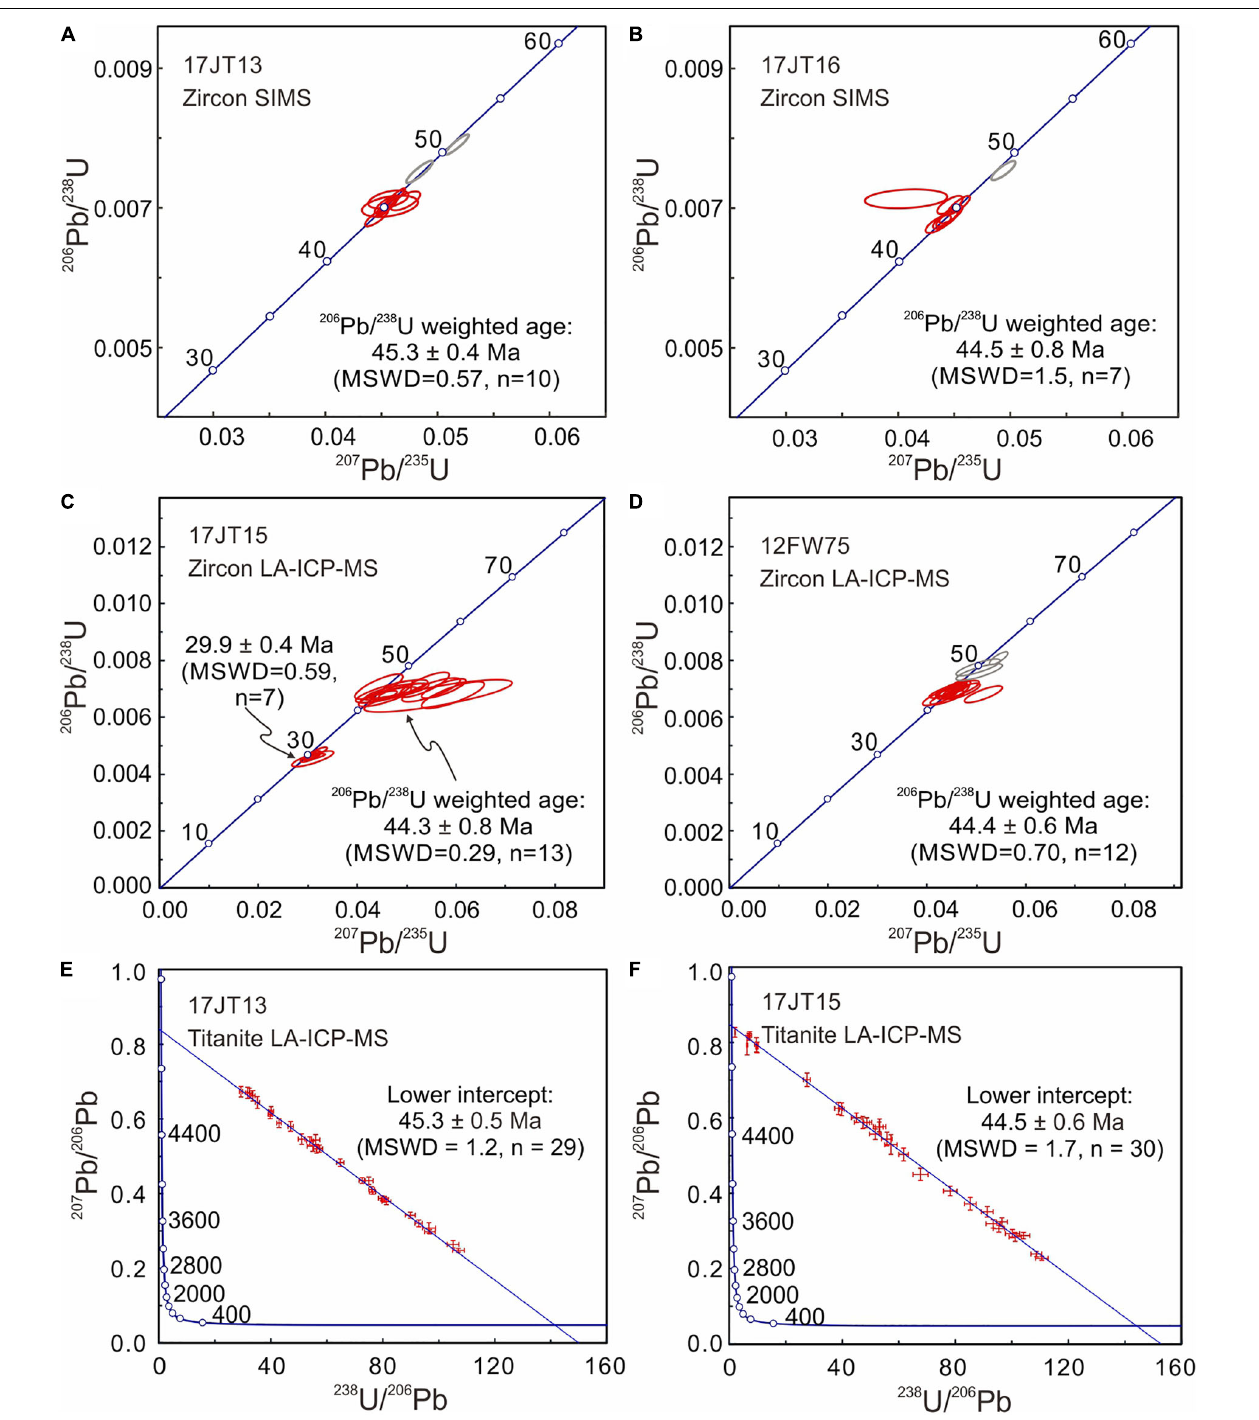
FIGURE 4 | Zircon U–Pb conventional Wetherill concordia (A–D) and titanite Tera–Wasserburg concordia (E,F) diagrams for Haweng granodiorite porphyries. Data-point error ellipses and error crosses are 2 σ . MSWD, Mean Square of Weighted Deviates.